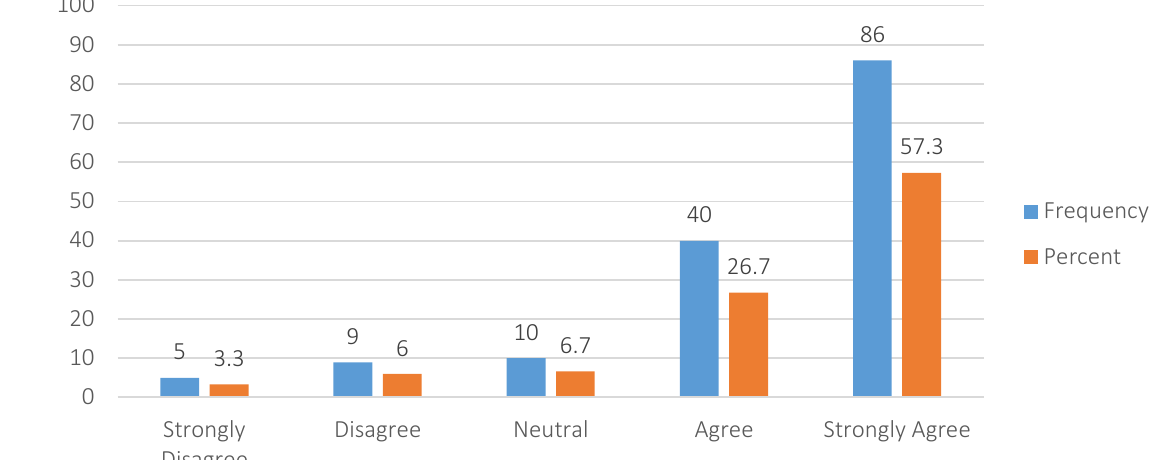
Figure 11. The adoption of MAPs improves competitive business